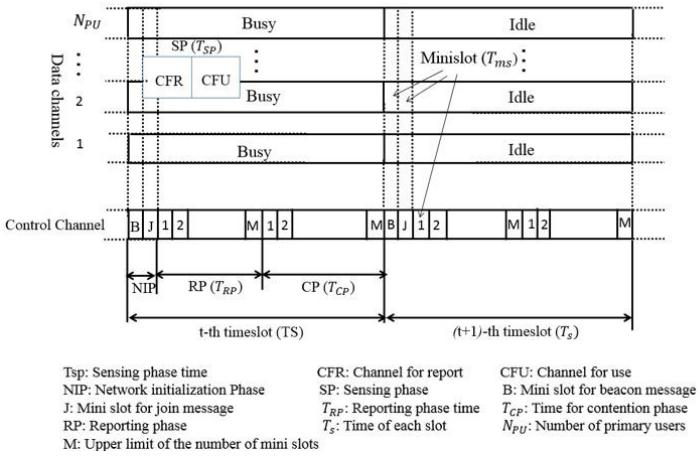
Figure 3. Operation of the ENC MAC protocol.